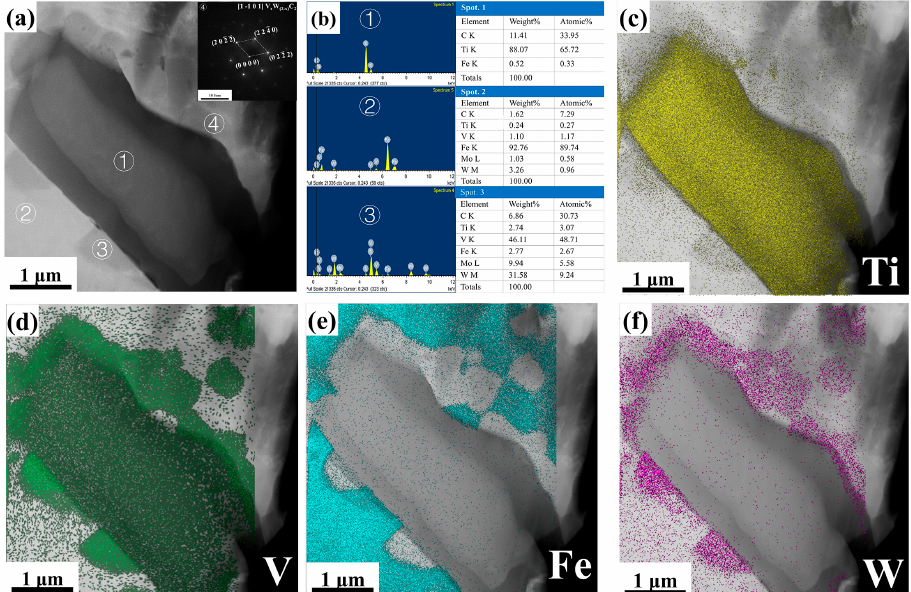
Figure 7. ( a ) The TEM images of TiC in the S390 MMCs and the SAED pattern of spot 4, ( b ) the corresponding EDS spectrum of 3 spots in ( a ), and ( c – f ) the EDS mapping.